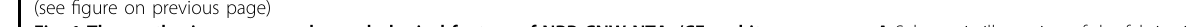
substrate, indicating a typical cross-linked porous struc- ture. From the high-resolution TEM image, it can be observed that the carbon species exhibited a partially graphitic structure (Fig. 1M). The TEM mapping of the as-obtained CNWs shown in Fig. 1N demonstrated the homogeneous dispersion of C, N, B and P, con fi rming the successful synthesis of multiple heteroatom-doped CNW materials.